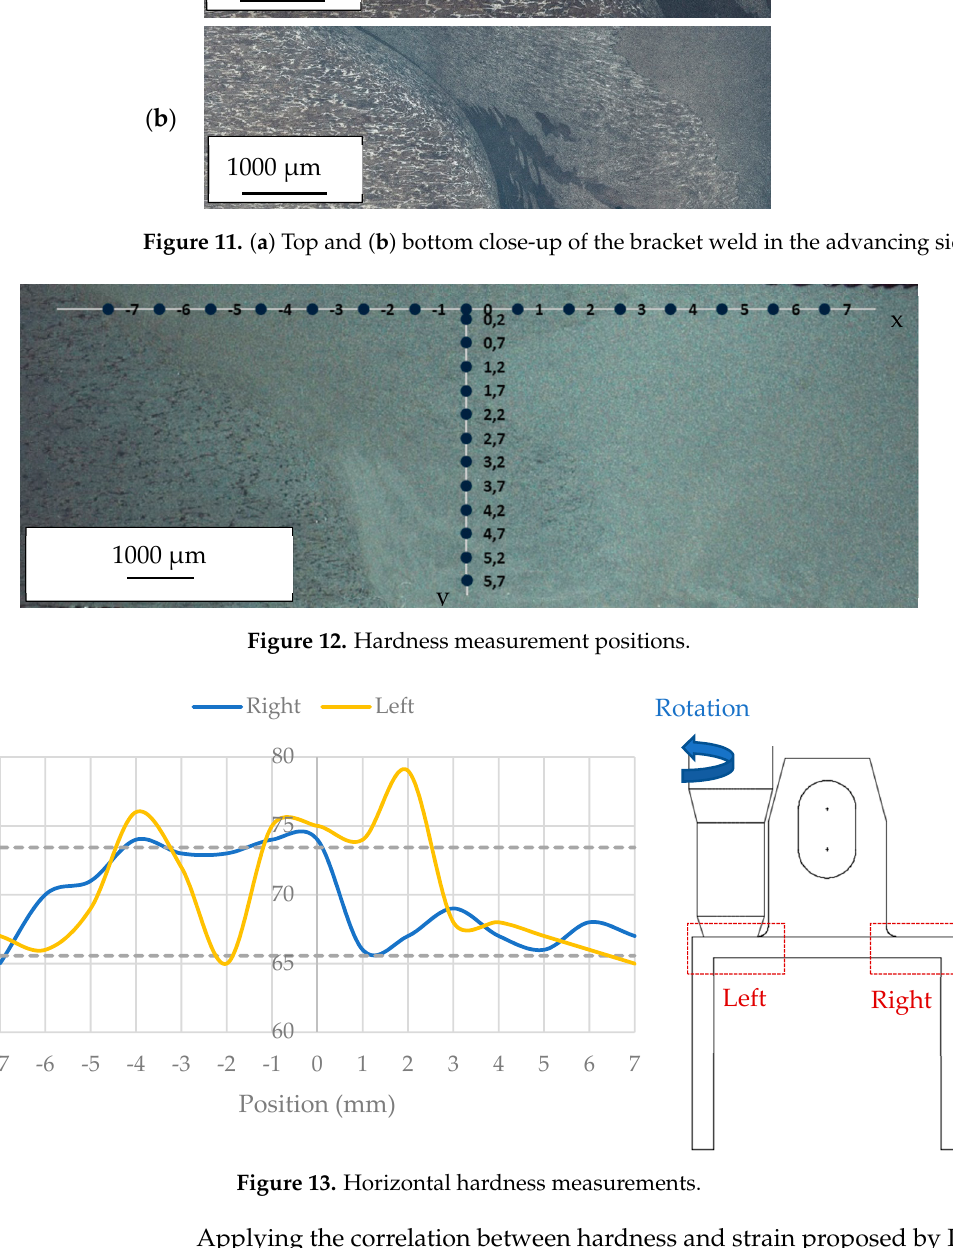
Figure 12. Hardness measurement positions .